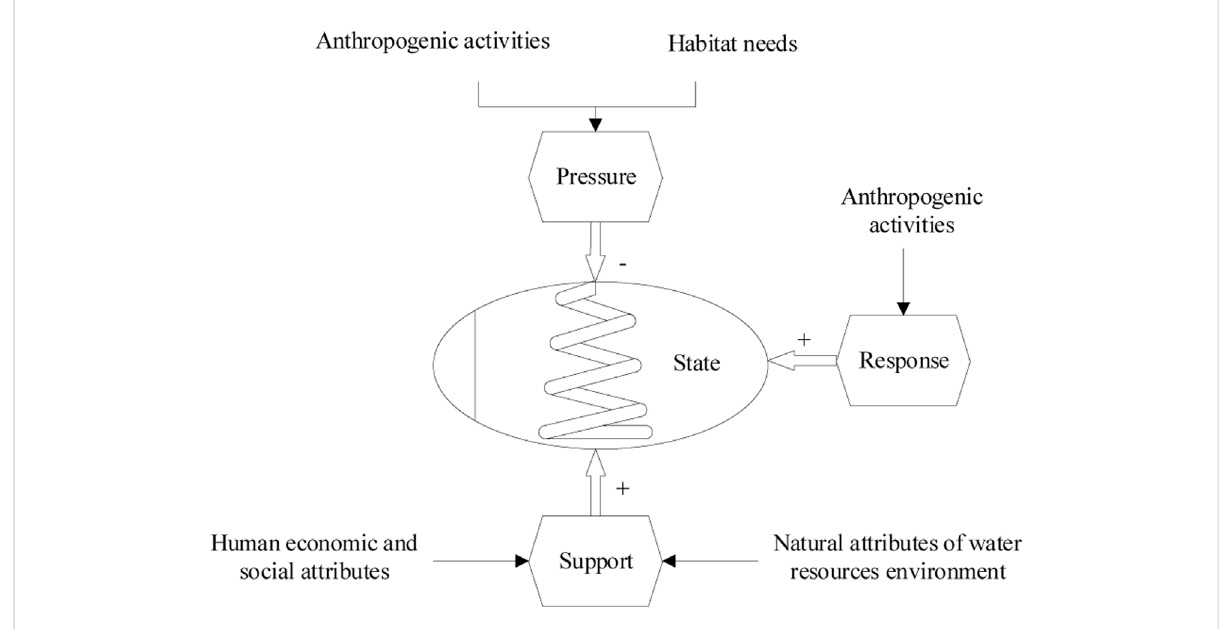
FIGURE 1 Pressure-state-response-support